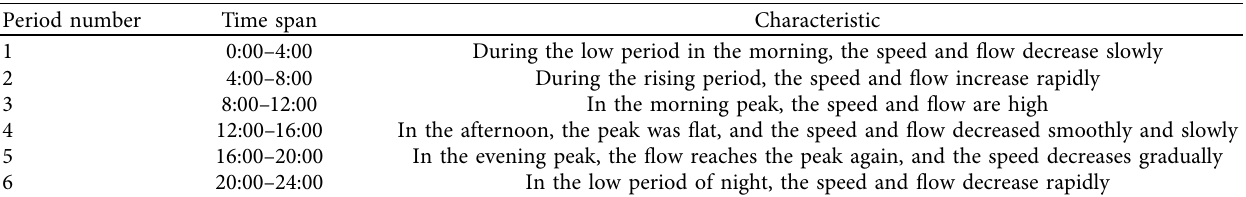
Table 4: The division of different periods of the day.